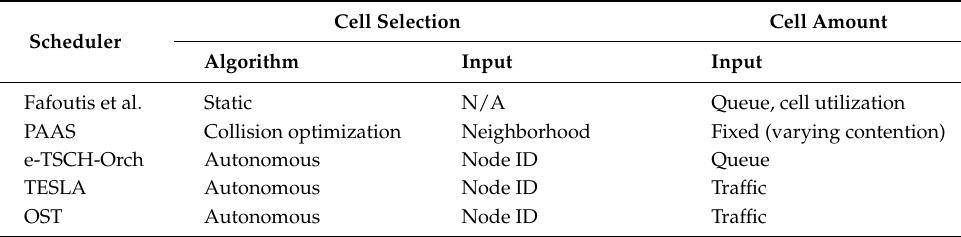
Table 10. Components of decentralized hybrid TSCH schedulers.